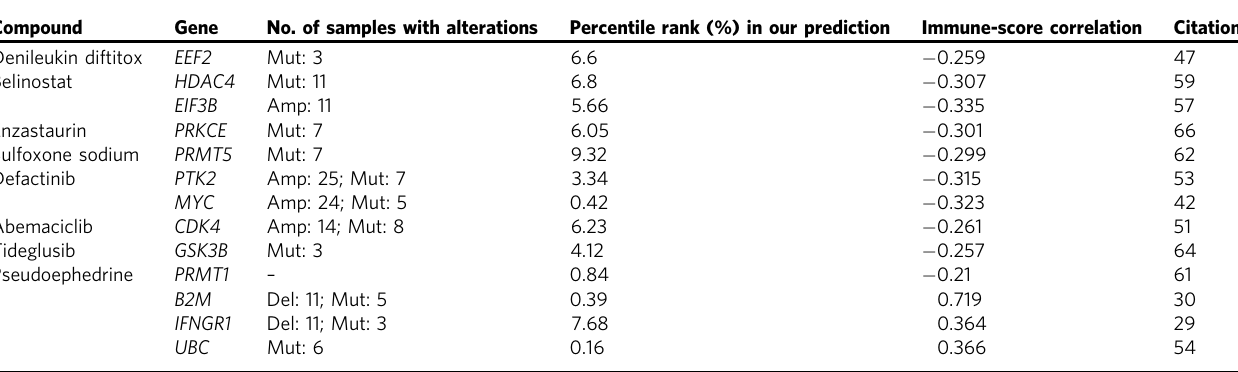
Fig. 4 Integration of the MHC I-association prediction with TCGA data. a Overlap analysis between the top 10% of genes in our MHC I-association prediction list and those genes whose expression are signi fi cantly correlated with immune in fi ltration score (absolute correlation ≥ 0.2) for the 34 TCGA cancer types. b The hierarchical clustering of cancer types using the 500 top immune-positive and -negative genes with the most variable immune in fi ltration correlation values across the 34 TCGA cancer types, revealing that cancer types in related tissue lineages were clustered together. The source data of all the panels in this fi gure are provided in the Source Data fi le. Table 1 Compounds, genetic alterations, and immune-in fi ltration score correlations of the selected genes identi fi ed for TCGA